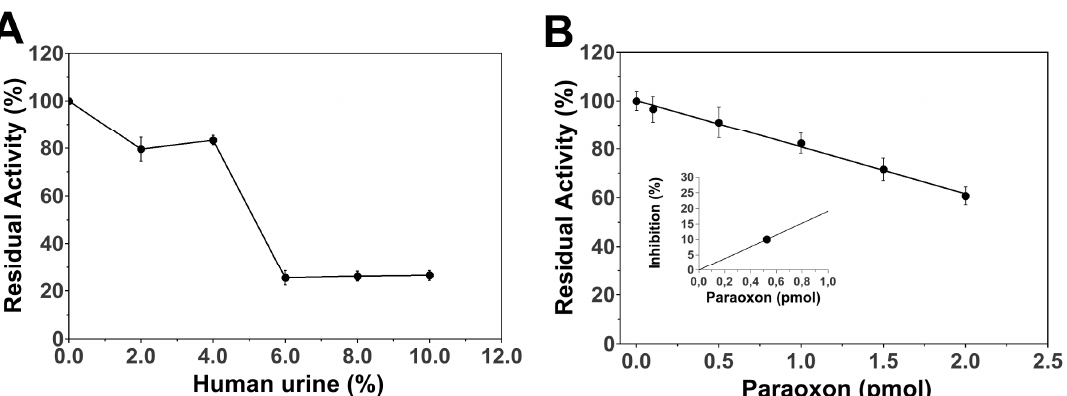
Figure 4. Determination of paraoxon in human urine. ( A ) Plot of EST2 residual activity in presence of increased amount of urine. ( B ) Plot of EST2 residual activity in 4% urine, in the presence of the increasing concentration of paraoxon. In the insert, the percentage of inhibition of EST2 in the presence of this increasing concentration of paraoxon. The error bars represent the SD from three independent experiments.